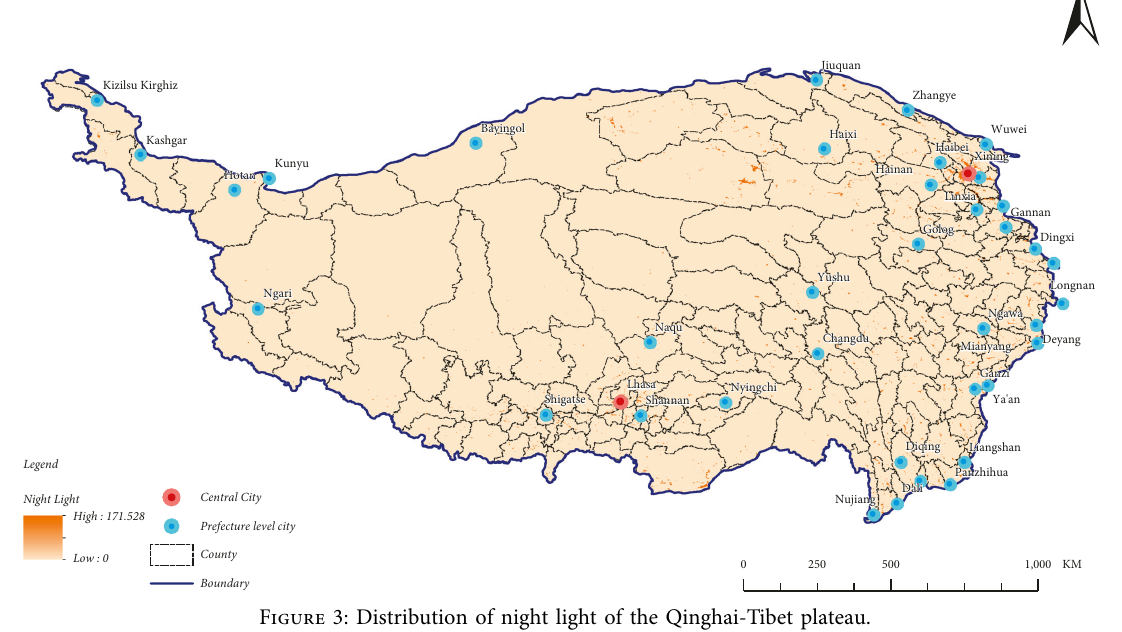
Figure 3: Distribution of night light of the Qinghai-Tibet plateau.